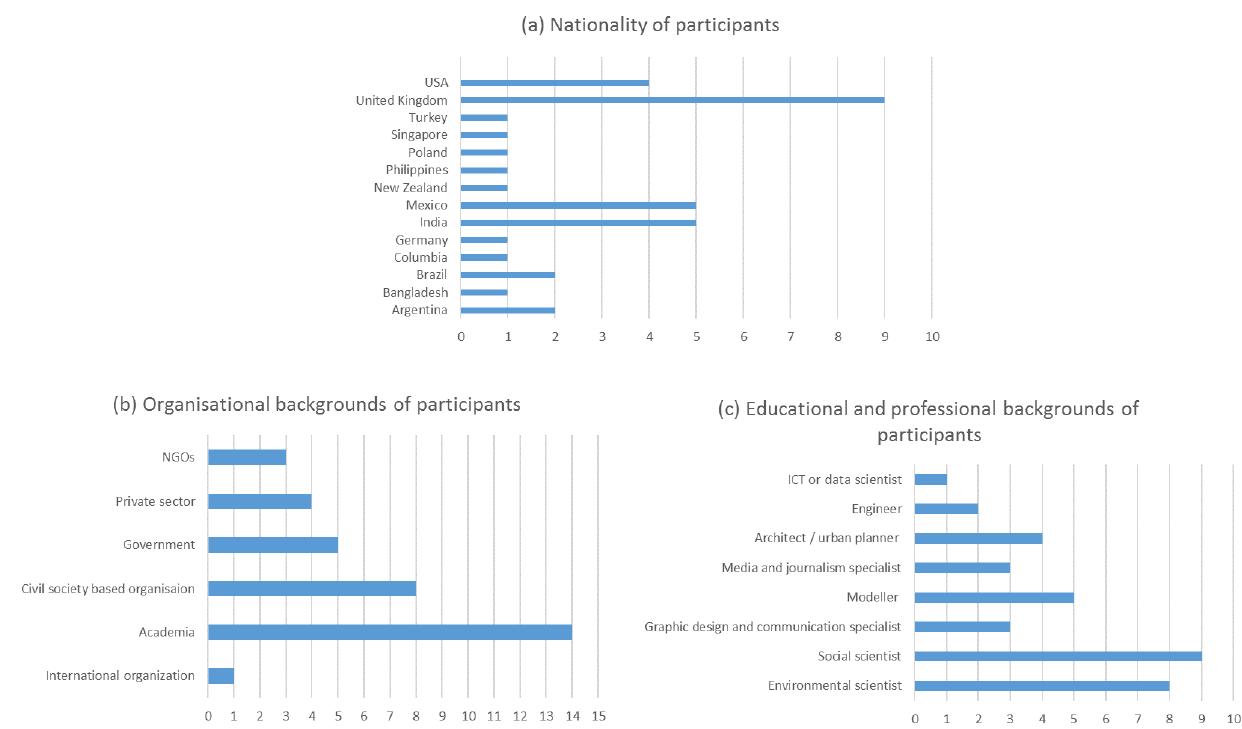
Figure 1. An overview of participant (a) nationalities, (b) organisational background, and (c) educational and professional background (data used from Water Youth Network, 2018). Table 1. Case study